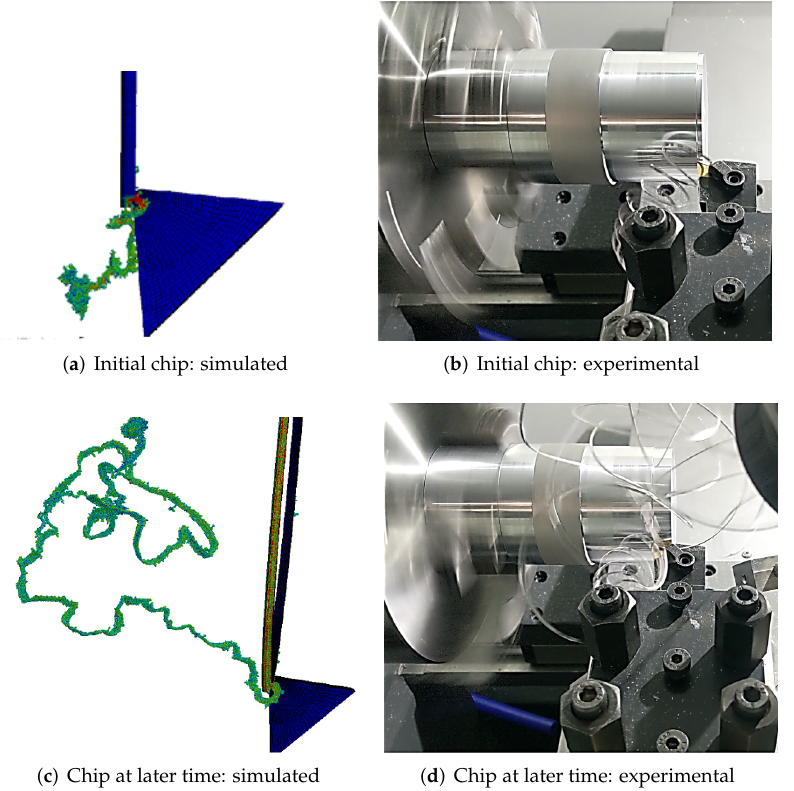
Figure 12. Comparison of simulated chip morphology with experimental chip at initial and later